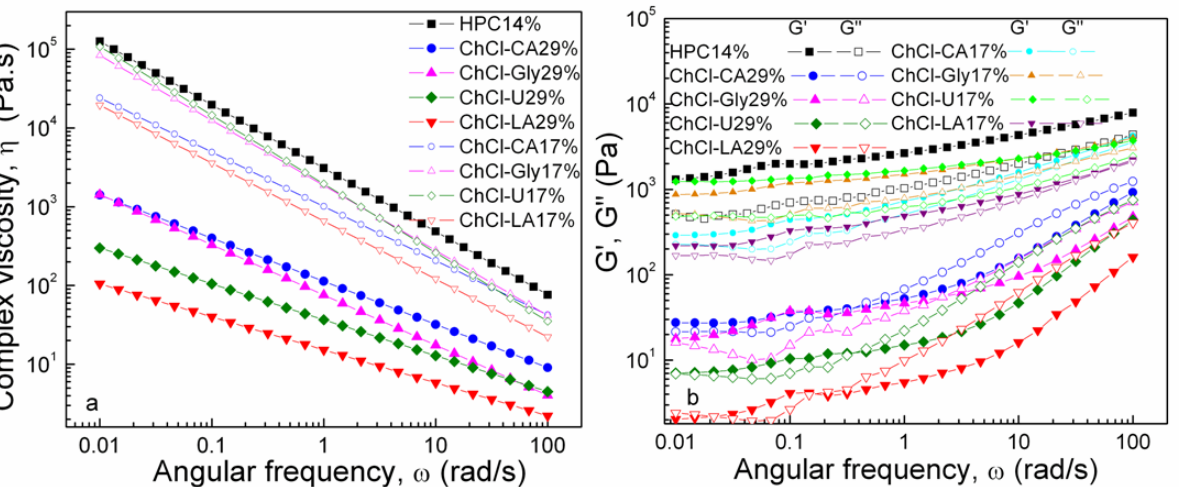
Figure 10. Complex viscosity and dynamic moduli, G ′ and G ′′ as functions of angular frequency at 20 °C.